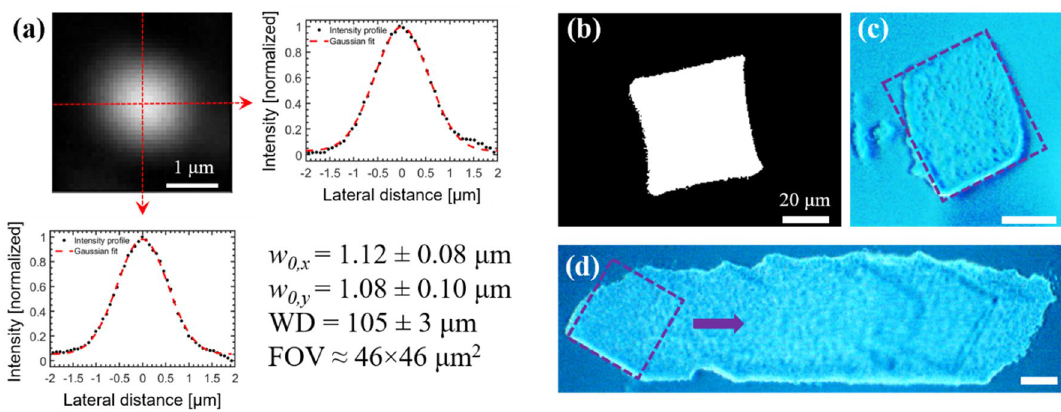
Figure 4. Optical performance of surgical probe. ( a ) Focal spot of miniaturized objective imaged with 20 × water immersion objective, 400 mm tube lens, and beam profiler. Beam profile was fit to Gaussian function to determine 1/ e 2 focal beam radius ( w 0 ). Uncertainties represent 95% confidence intervals for the Gaussian fit to the vertical and horizontal profiles. Scale bar is 1 μm. ( b ) Binary image of 46 × 46 μm 2 FOV at the probe focal plane. ( c ) Ablation of borosilicate glass coverslip with surgical probe. The size of the ablation FOV created on the coverslip agrees well with FOV imaging results. ( d ) Scanning the coverslip laterally enables formation of an ablation trench across the glass surface. Scale bars are 20